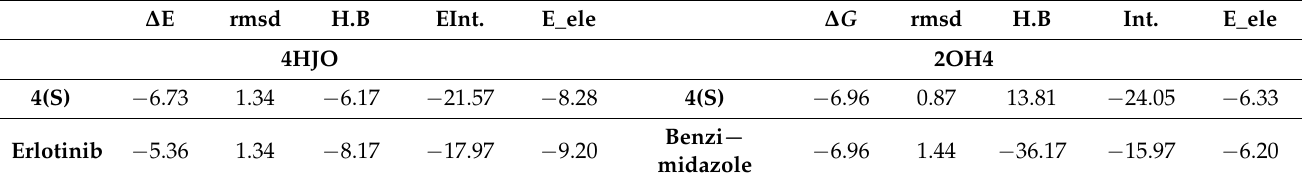
Table 5. The binding affinity for compound 4 with docking score (kcal/mol) against EGFR and